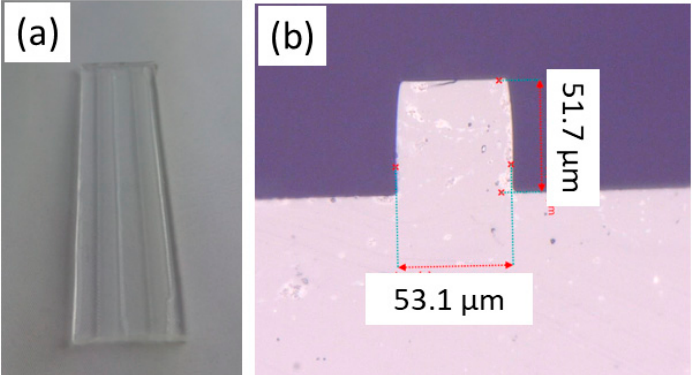
Figure 2. Picture of the Sylgard 184 stamp ( a ) camera picture whole stamp sample (total length of the PDMS stamp 8 cm), ( b ) microscope detail picture of the 50 × 50 μ m channel.